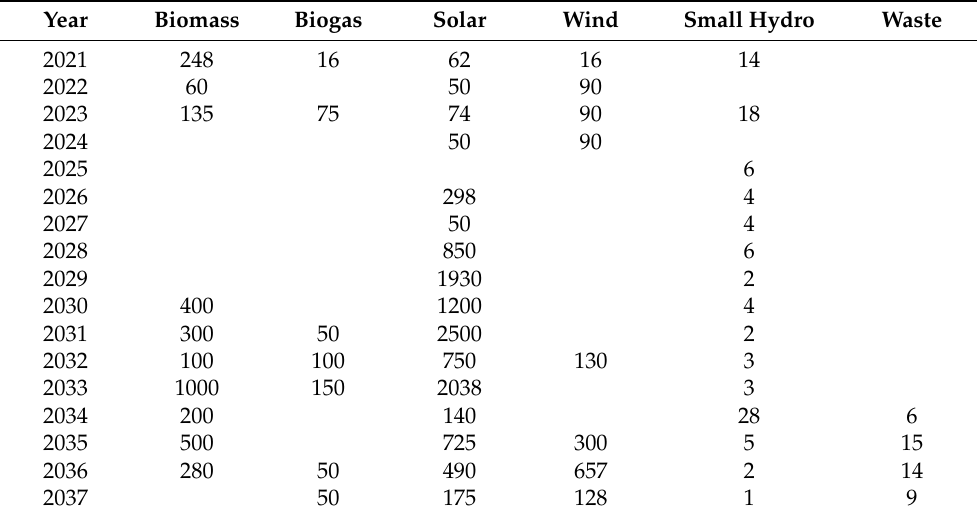
Table A6. Committed renewable generation units (MW).